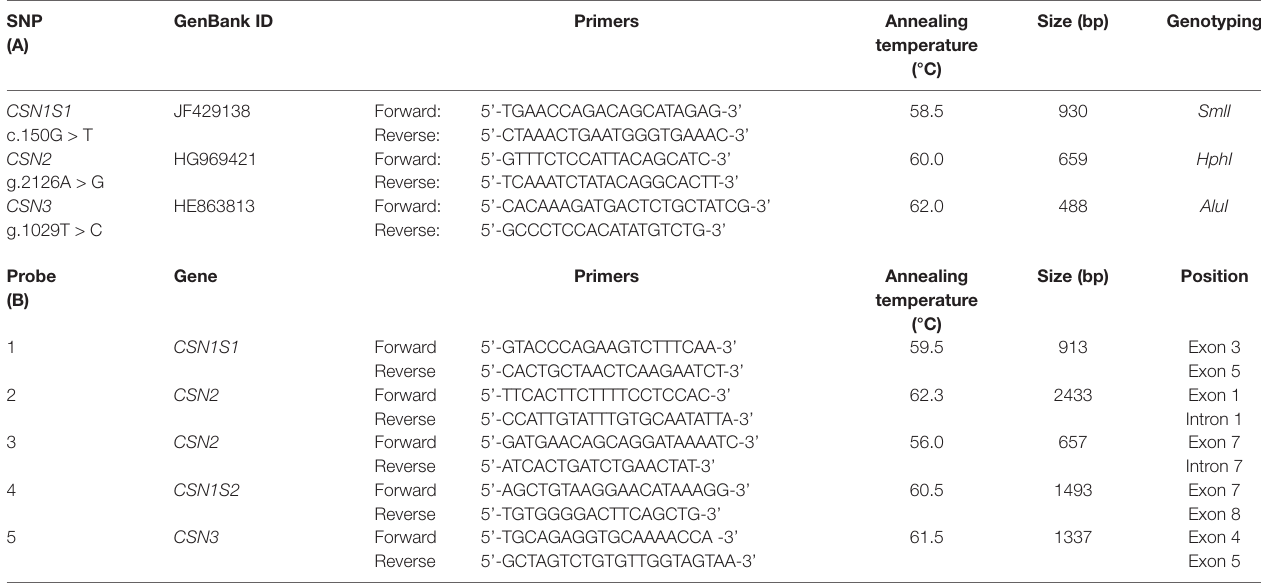
TABLE 1 | Sequences and annealing temperature of the primers used for the genotyping by PCR-RFLP assays (A) and for preparation of the FISH probes covering the casein genes cluster (B) . All primers were designed on wild feral camel genome sequence available in gene bank (EMBL acc. no. AGVR01039100.1), and multiple alignment confirmed 100% similarity in the other